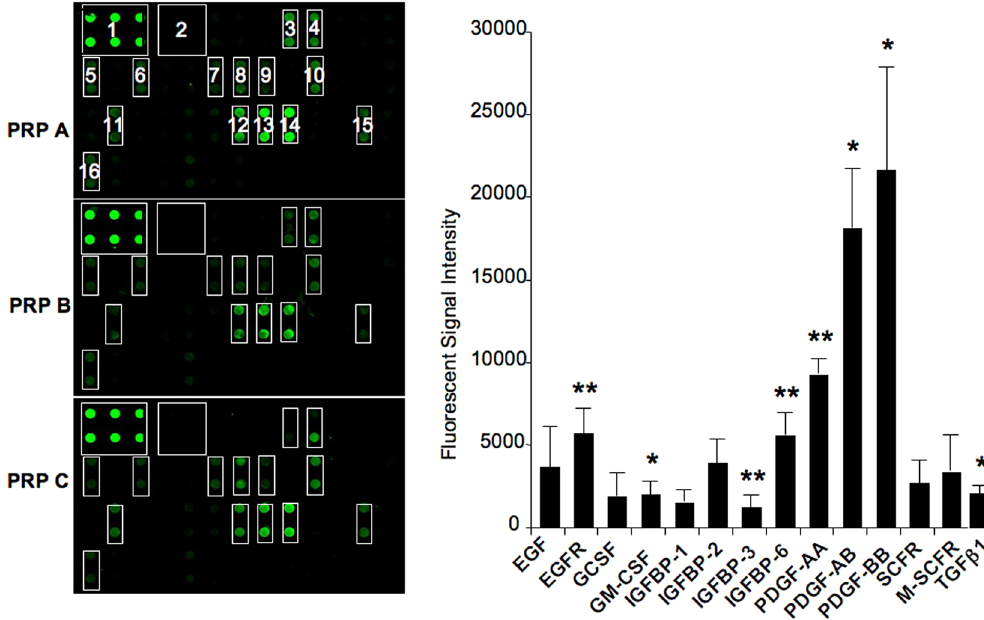
Figure 2. PRP profiling. Cytokines released from PRPs were detected using the RayBio C-Series Human Growth factor Antibody kit. Left panel: Images of arrays probed with indicated PRPs. Cytokines are spotted in duplicate and those released from PRP appear as green dots. The positions and names of cytokines that generated a detectable signal are as follows. 1: Positive control; 2: Negative control; 3: EGF; 4: EGFR; 5: GCSF; 6: GM-CSF; 7: IGFBP-1; 8: IGFBP-2; 9: IGFBP-3; 10: IGFBP-6; 11: M-CSFR; 12: PDGF-AA; 13: PDGF-AB; 14: PDGF-BB; 15: SCFR; 16: TGFb1. Cytokines that were present on the array and non detectable are as follows: amphiregulin (AR, AREG), bFGF, b-NGF, FGF-4, FGF-6, FGF-7, GDNF, HB-EGF, HGF, IGFBP-4, IGF-I, IGF-I R, IGF-II, M-CSF, NT-3, NT-4, PDGF R a, PDGF R b, PLGF, SCF, TGF alpha, TGF beta2, TGF beta3,VEGF- A,VEGFR2,VEGFR3,VEGF-D. Right panel: factors/cytokines presenting a detectable fluorescent signal are indicated. Values are the fluorescence means ± SEM (n = 3 individual PRPs.) * p < 0.05; ** p <